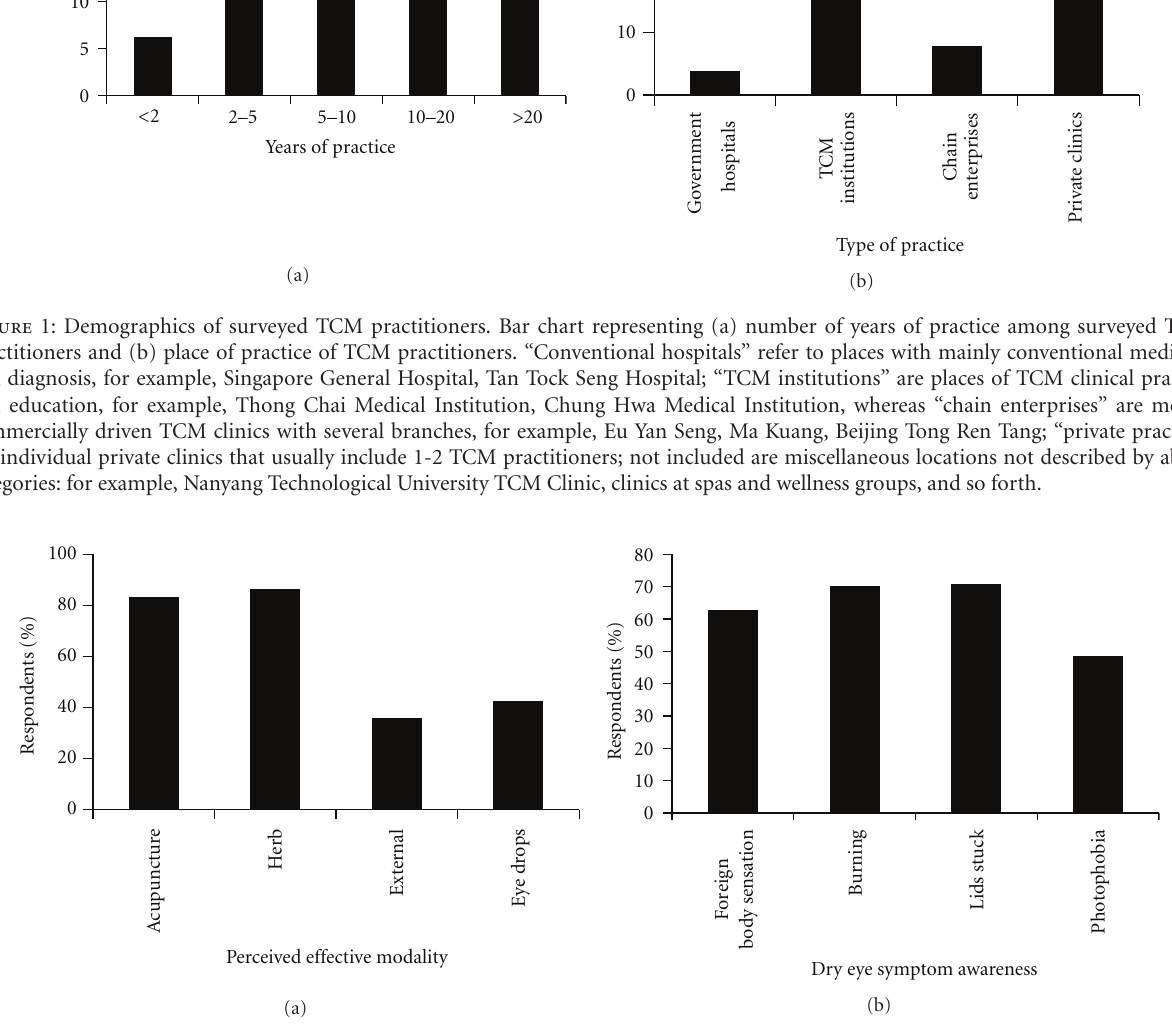
Figure 2: Knowledge of TCM practitioners about dry eye disease. (a) Bar chart representing modality of TCM treatment that practitioners believe to be e ff ective in treating dry eye. “Herbal medication” represents oral herbal decoctions or patent pills; “external treatment” refers to modalities such as hot compress, external herbal wash and eye drops refer to conventional topical eye drops. (b) Bar chart showing the dry eye symptoms that TCM practitioners are aware